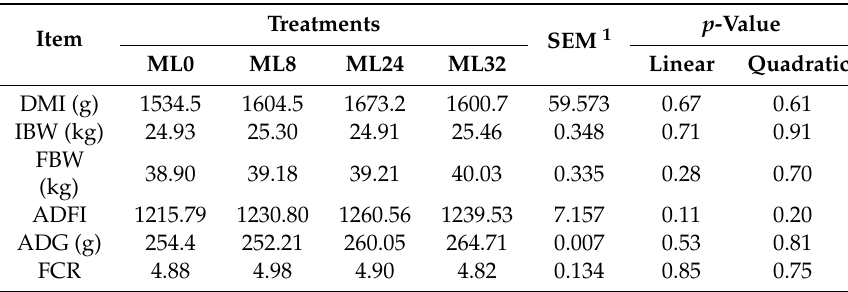
Table 2. E ff ects of di ff erent dietary mulberry leaf hay proportion treatments on the dry matter intake and growth performance of sheep.